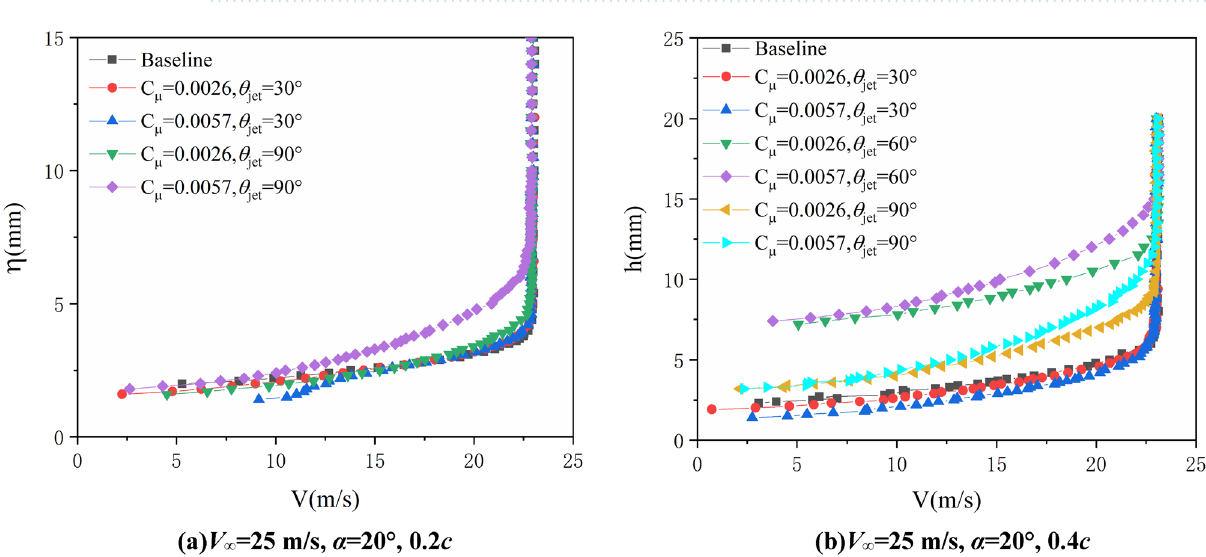
Figure 11. Test results of the boundary layer velocity profiles ( V ∞ = 25 m/s, α =